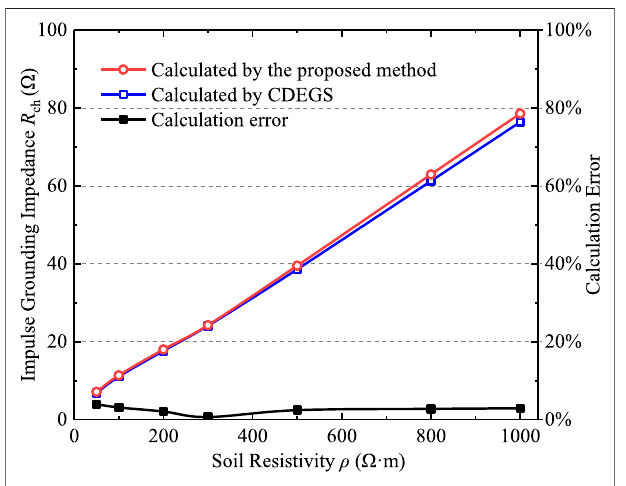
FIGURE 5 | Voltage response curve of grounding electrode when ρ is 500 Ω m.